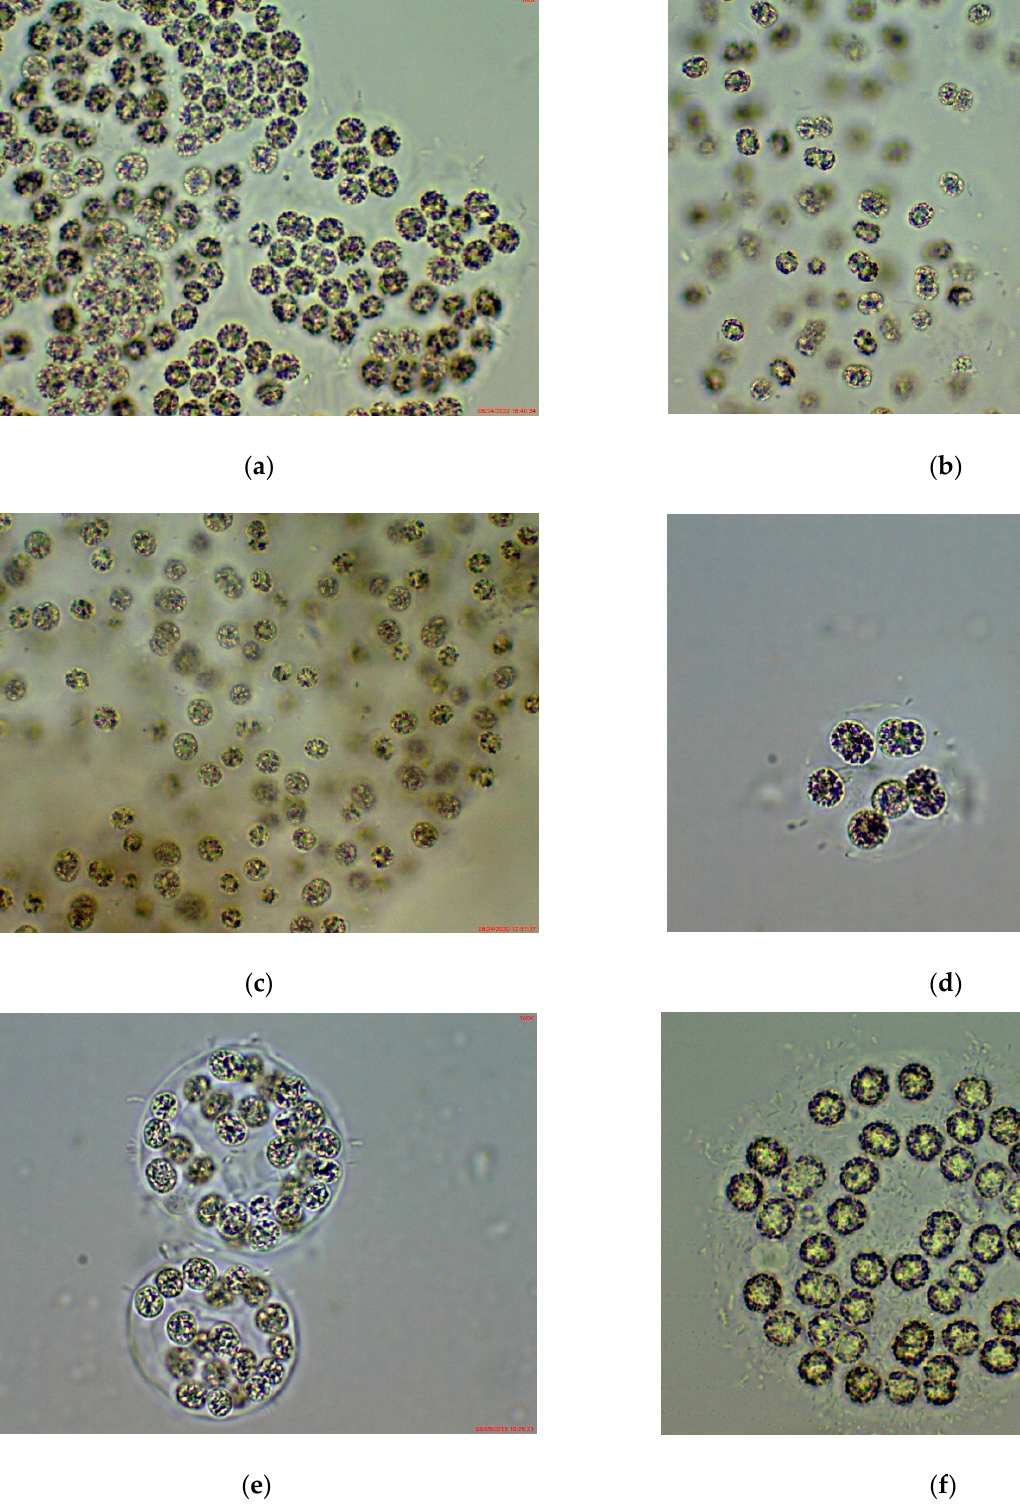
Figure 5. Examples of Microcystis from different Bulgarian waterbodies (under immersion and objective 100×): ( a )— M. wesenbergii from the reservoir Sinyata Reka; ( b ) — M. aeruginosa from the reservoir Sinyata Reka; ( c ) — M. aeruginosa from the reservoir Mandra (Eastern part); ( d )— M. wesenbergii from the reservoir Poroy; ( e )— M. wesenbergii from the lake Durankulak; ( f )— M. wesenbergii from the reservoir Izvornik 2.